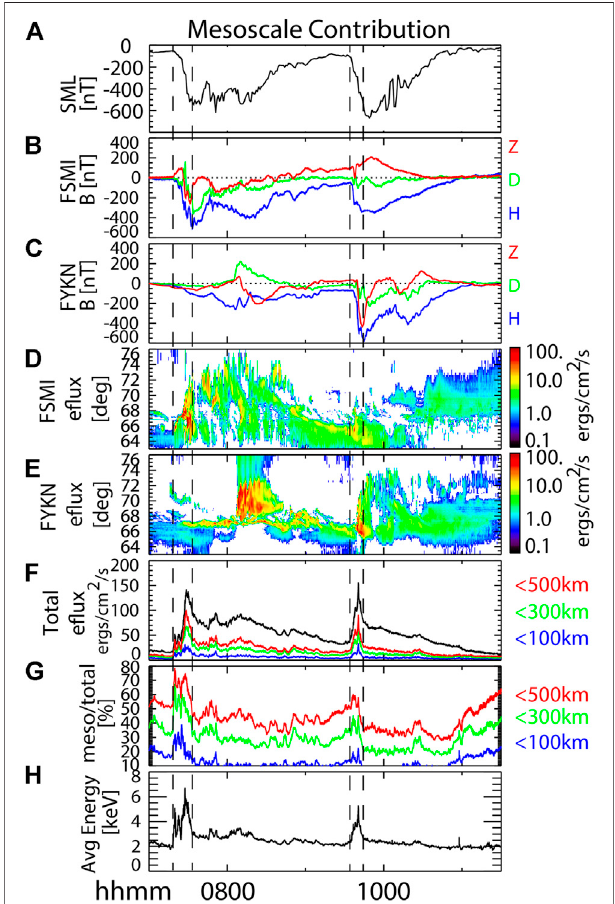
FIGURE 7 | (A) SML index. (B) Magnetometer data from Fort Smith, near the fi rst substorm onset. (C) Magnetometer data from Fort Yukon, which wasclosertothesecondsubstorm ’ sonset. (D) KeogramofFortSmithenergy fl ux. (E) Keogram of Fort Yukon energy fl ux. (F) Total energy fl ux observed by the ASI mosaic plotted in black. Total energy fl ux contributed by scale sizes under 500 km, 300 and 100 km plotted in red, green, and blue, respectively. (G) Percent of the total energy fl ux contributed by scale sizes under 500 km, 300 km, and 100 km plotted in red, green, and blue, respectively. (H) Average of the average energy observed over the ASI mosaic. The vertical dashed lines mark the start of the sharp increase in total energy fl ux and the end of the sharp decrease in total energy fl ux that occurs duringthesubstormexpansionphaseforeachsubstorm(07:18and07:33:20 for the fi rst, 09:34:52 and 09:45 UT for the